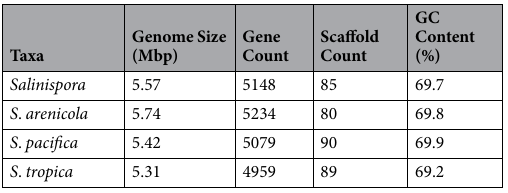
Table 1. Average genome statistics for the genus Salinispora and each species.